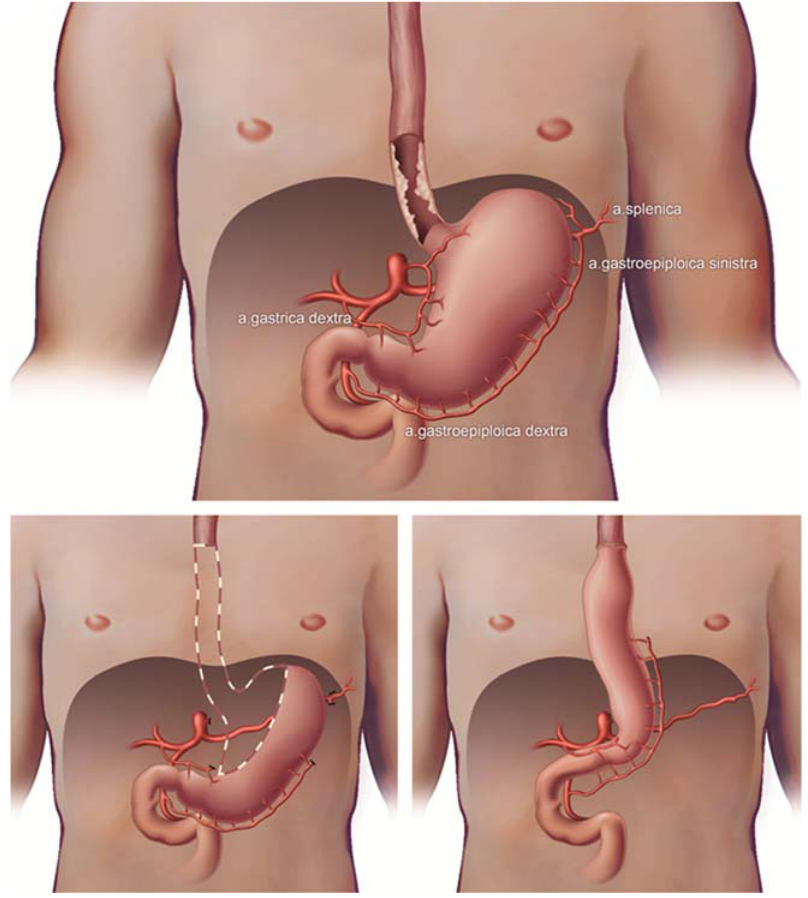
Figure 1. Esophageal cancer with gastric vascularization, esophagectomy and gastric tube Esophageal cancer with gastric vascularization, esophagectomy and gastric tube reconstruction with only one artery left (gastroepiploic artery). reconstruction with only one artery left (gastroepiploic